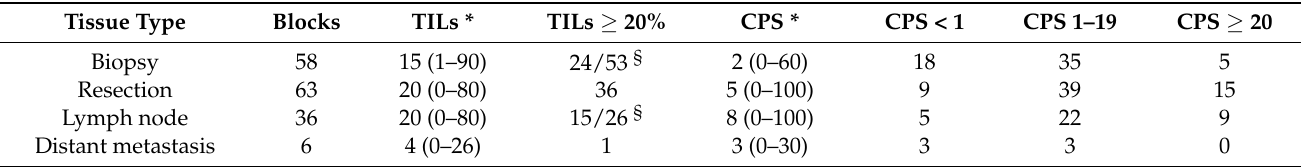
Table 2. Tissue specimen